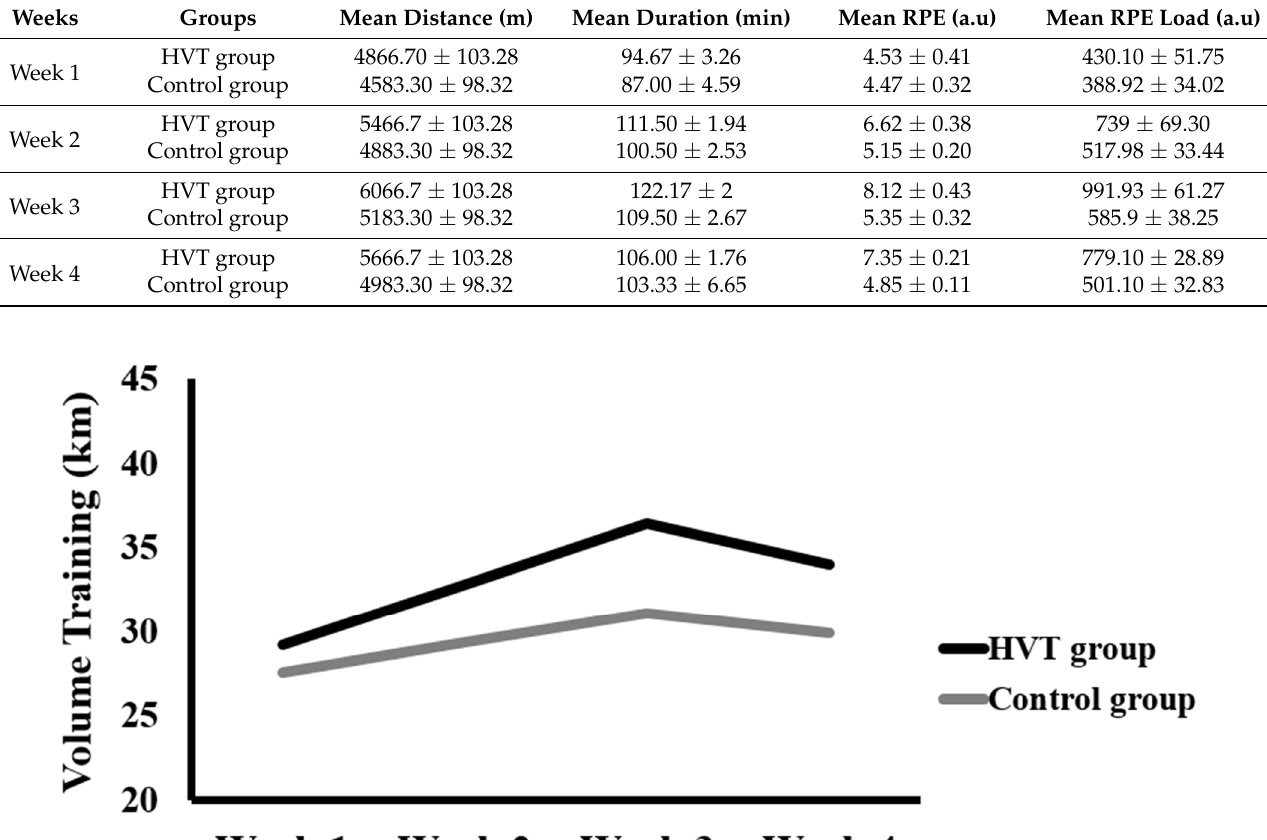
Table 1. Mean volume training and rating perceived exertion load in both groups during 4 weeks of training.